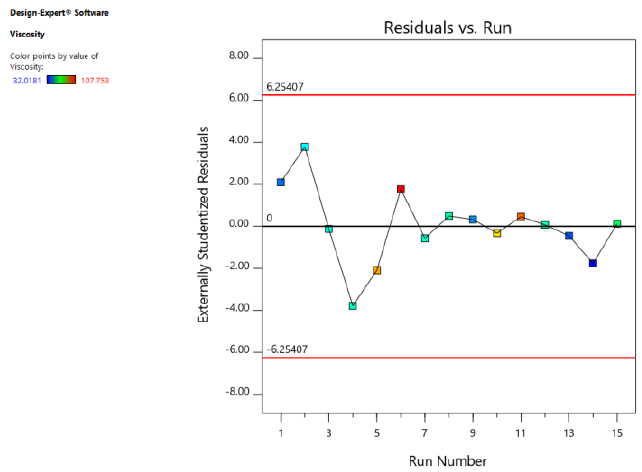
Figure A2. The normal probability plot of residuals versus predicted response values.